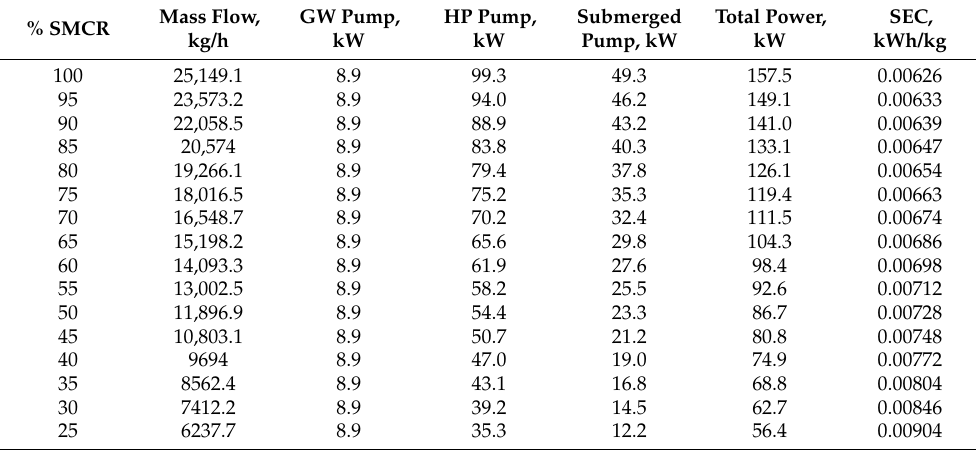
Table 10. Power consumption for each unit.